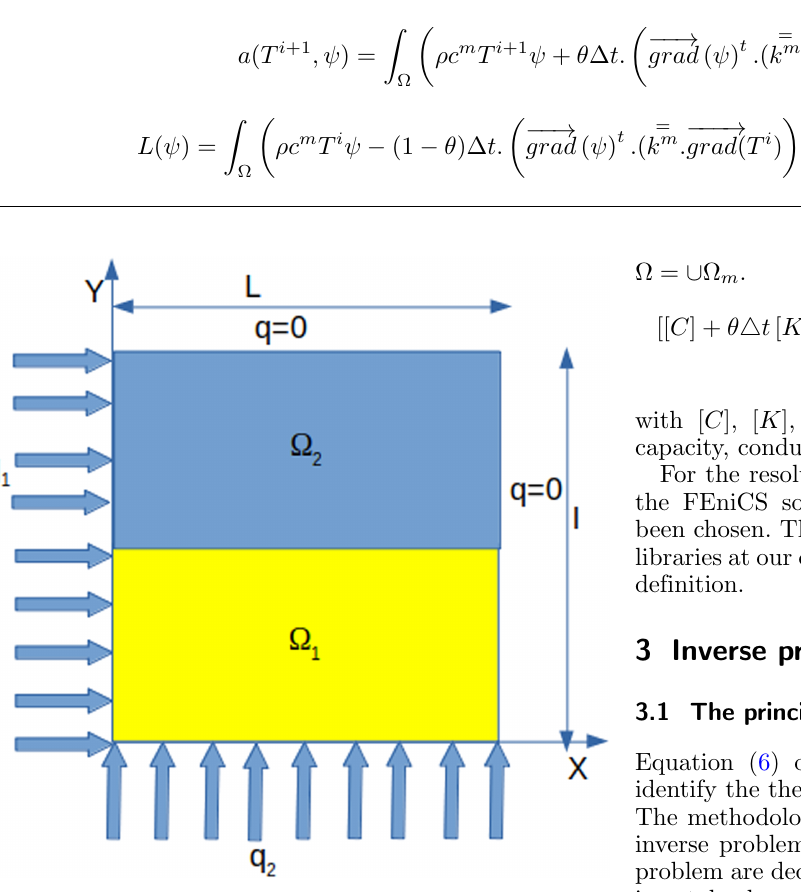
Fig. 1. Geometry of the